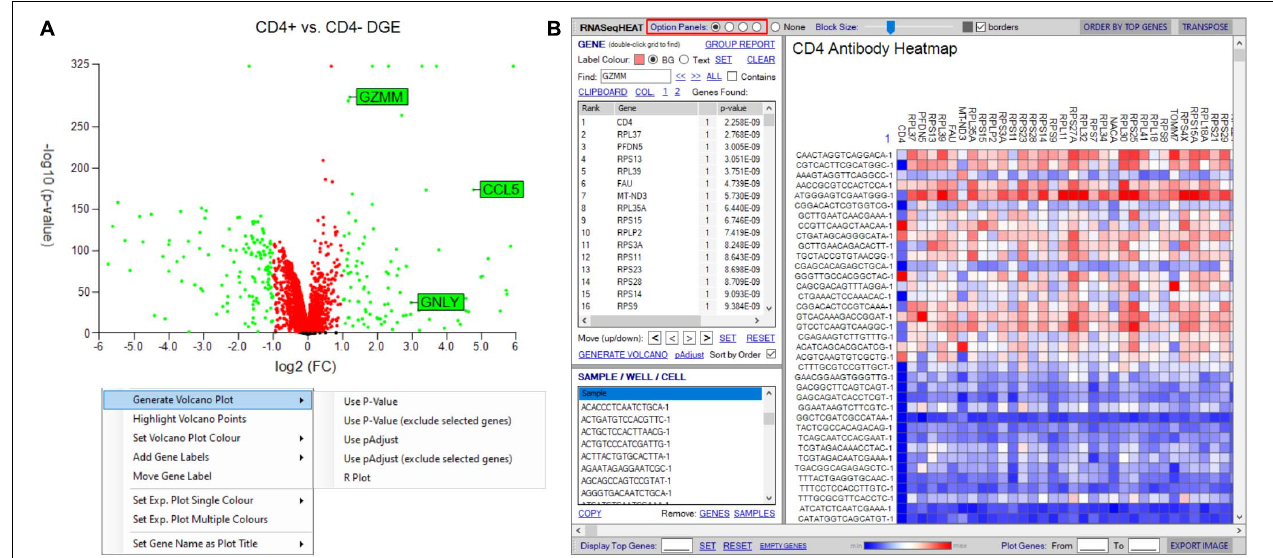
FIGURE 8 | Tools to visualize differential gene expression. (A) Volcano plot for differential expression analysis between two groupings/samples. User-defined thresholds can be set for fold change and significance, visualized according to color (red and green represent genes above different preselected fold change (FC) and significance ( p -value). Right-click menu provides options for addition and formatting of gene labels, plot coloring, and exclusion of selected genes. (B) RNASeqHEAT enables generation of a heatmap of selected genes as shown on horizontal axis and with selected samples on vertical axis. Option panel (highlighted in red) allows customization.